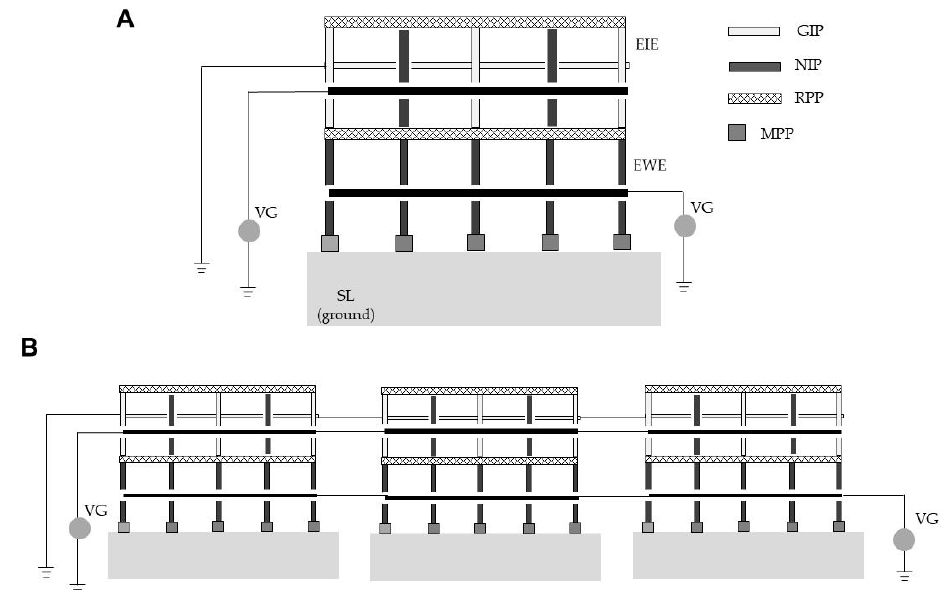
Figure 2. Diagrams of a combined apparatus (EIE/EWE) for simultaneous control of weeds and flies emerging from soil ( A ) and triplicate EIE/EWEs ( B ). Abbreviations are given in the legend of Figure 1.